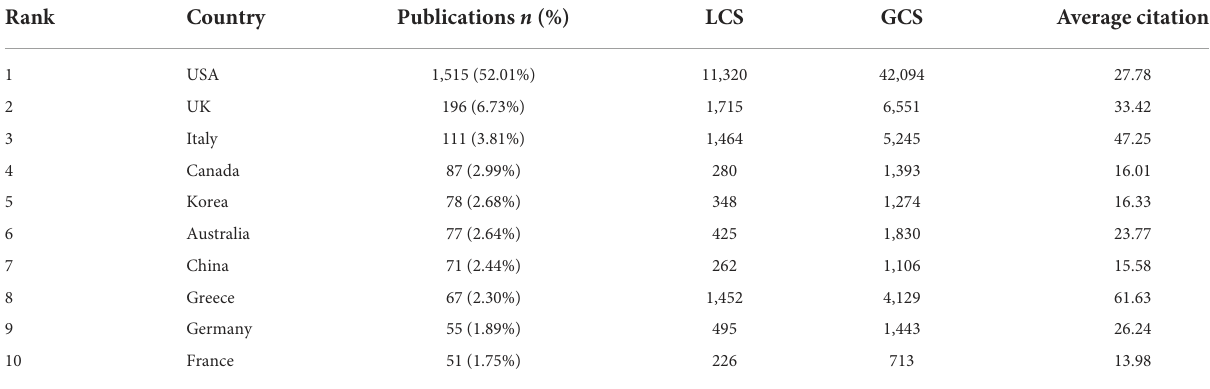
TABLE 1 Top 10 producing countries for research on electronic cigarette.